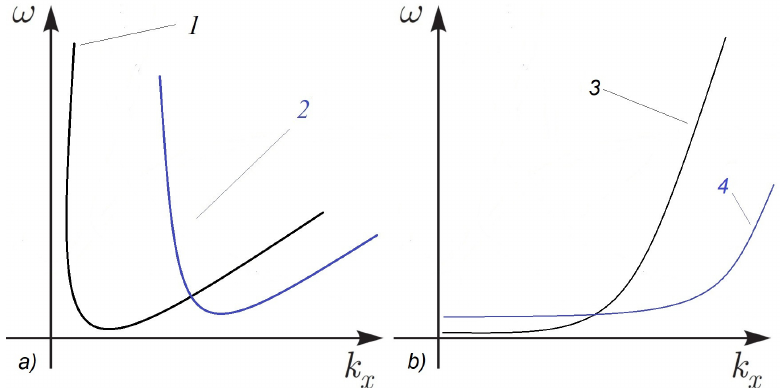
Figure 2. Intersection of two dispersion curves shifted from each other defines the satisfaction of phase matching condition. For waves ( a ) in an external vertical magnetic field curve 1 is a dispersion curve for magneto-Rossby wave with ω = ω MR wave with ω = ω MR dispersion curve for magneto-Rossby wave with ω = ω MR magneto-Rossby wave with ω = ω MR